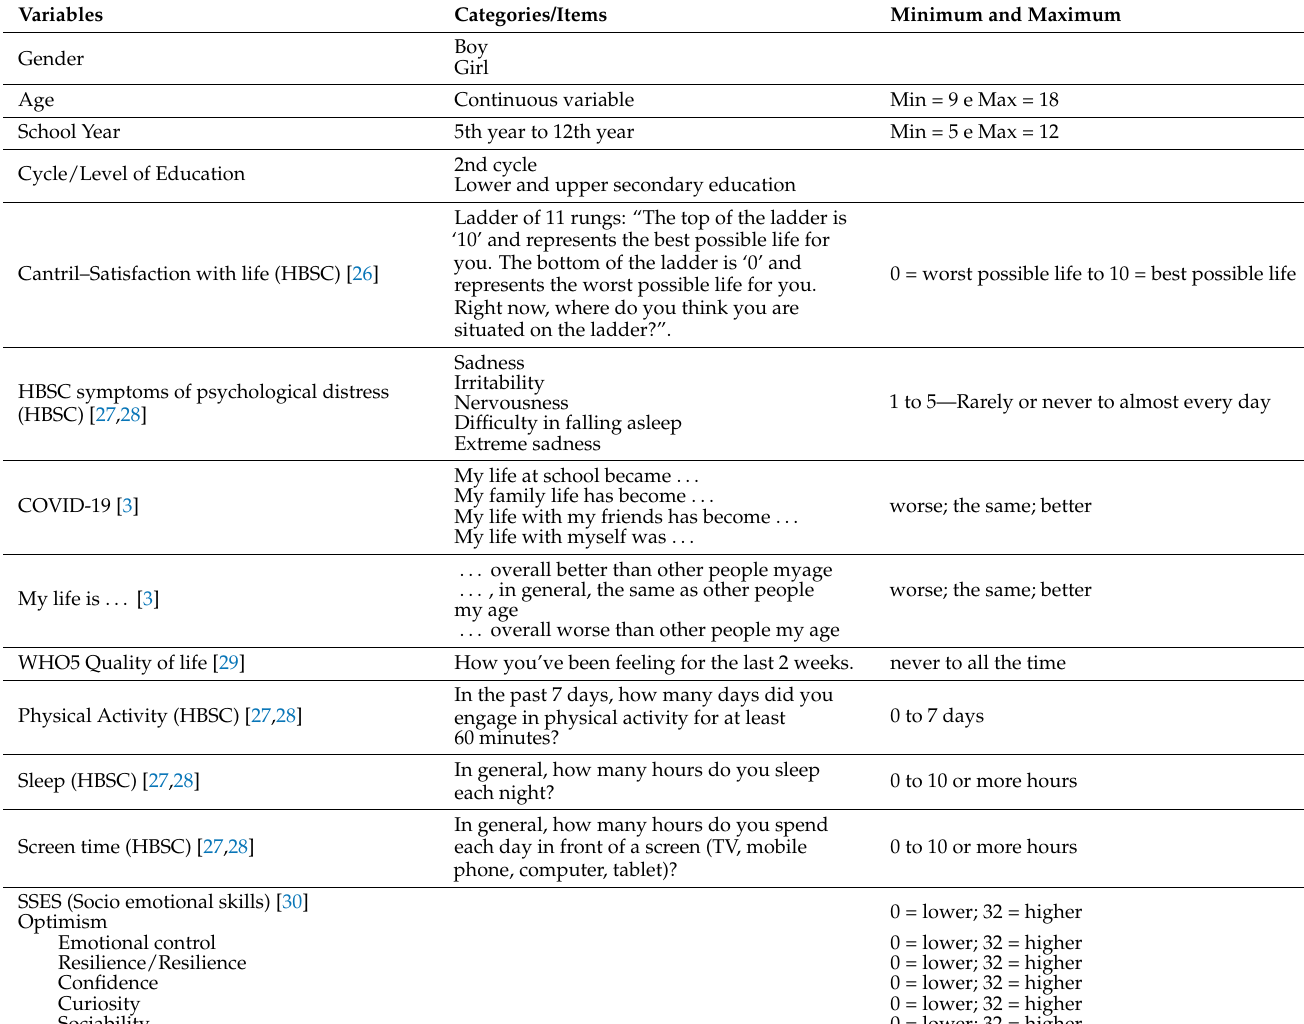
Table 2. Measures and variables under